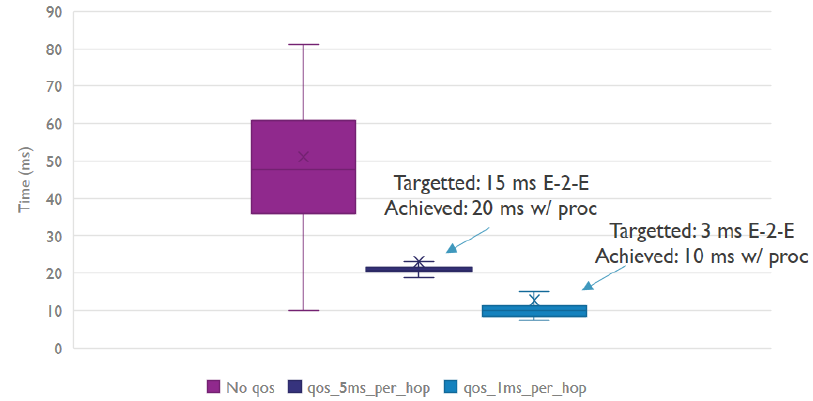
Figure 22. Targeted latency for three hops.